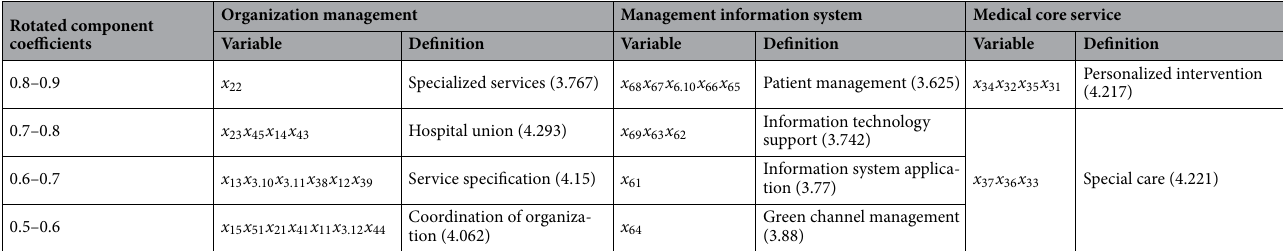
Table 9. Chronic disease management service system elements and average scores of service nodes under the elements. The values in brackets indicate the mean of the system